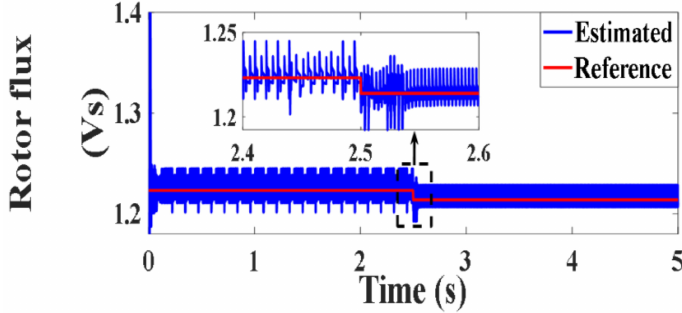
Figure 48. Rotor flux under MPDTC